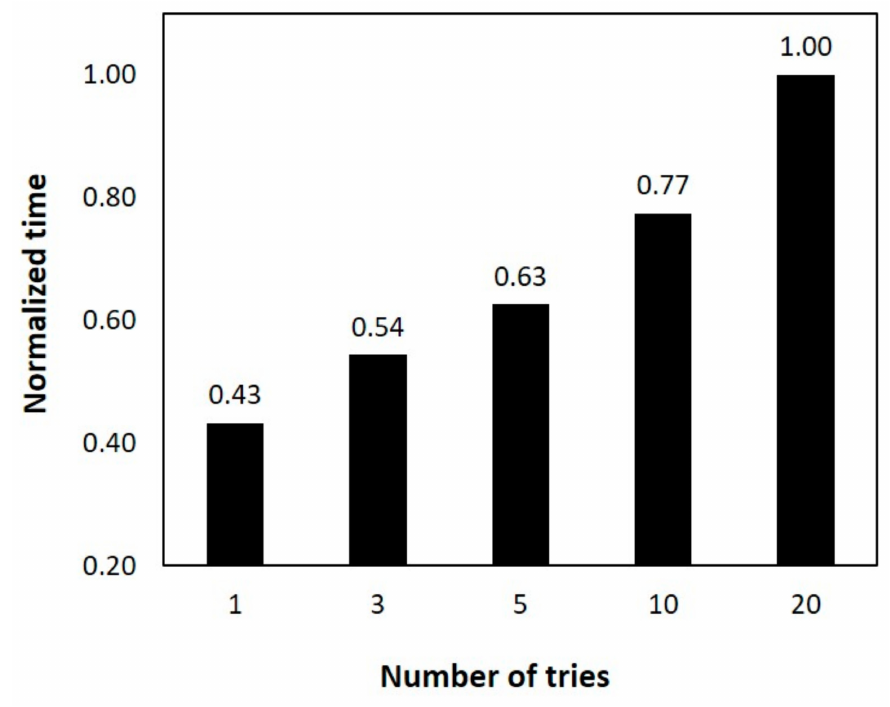
Figure 15. Normalized simulation time for different